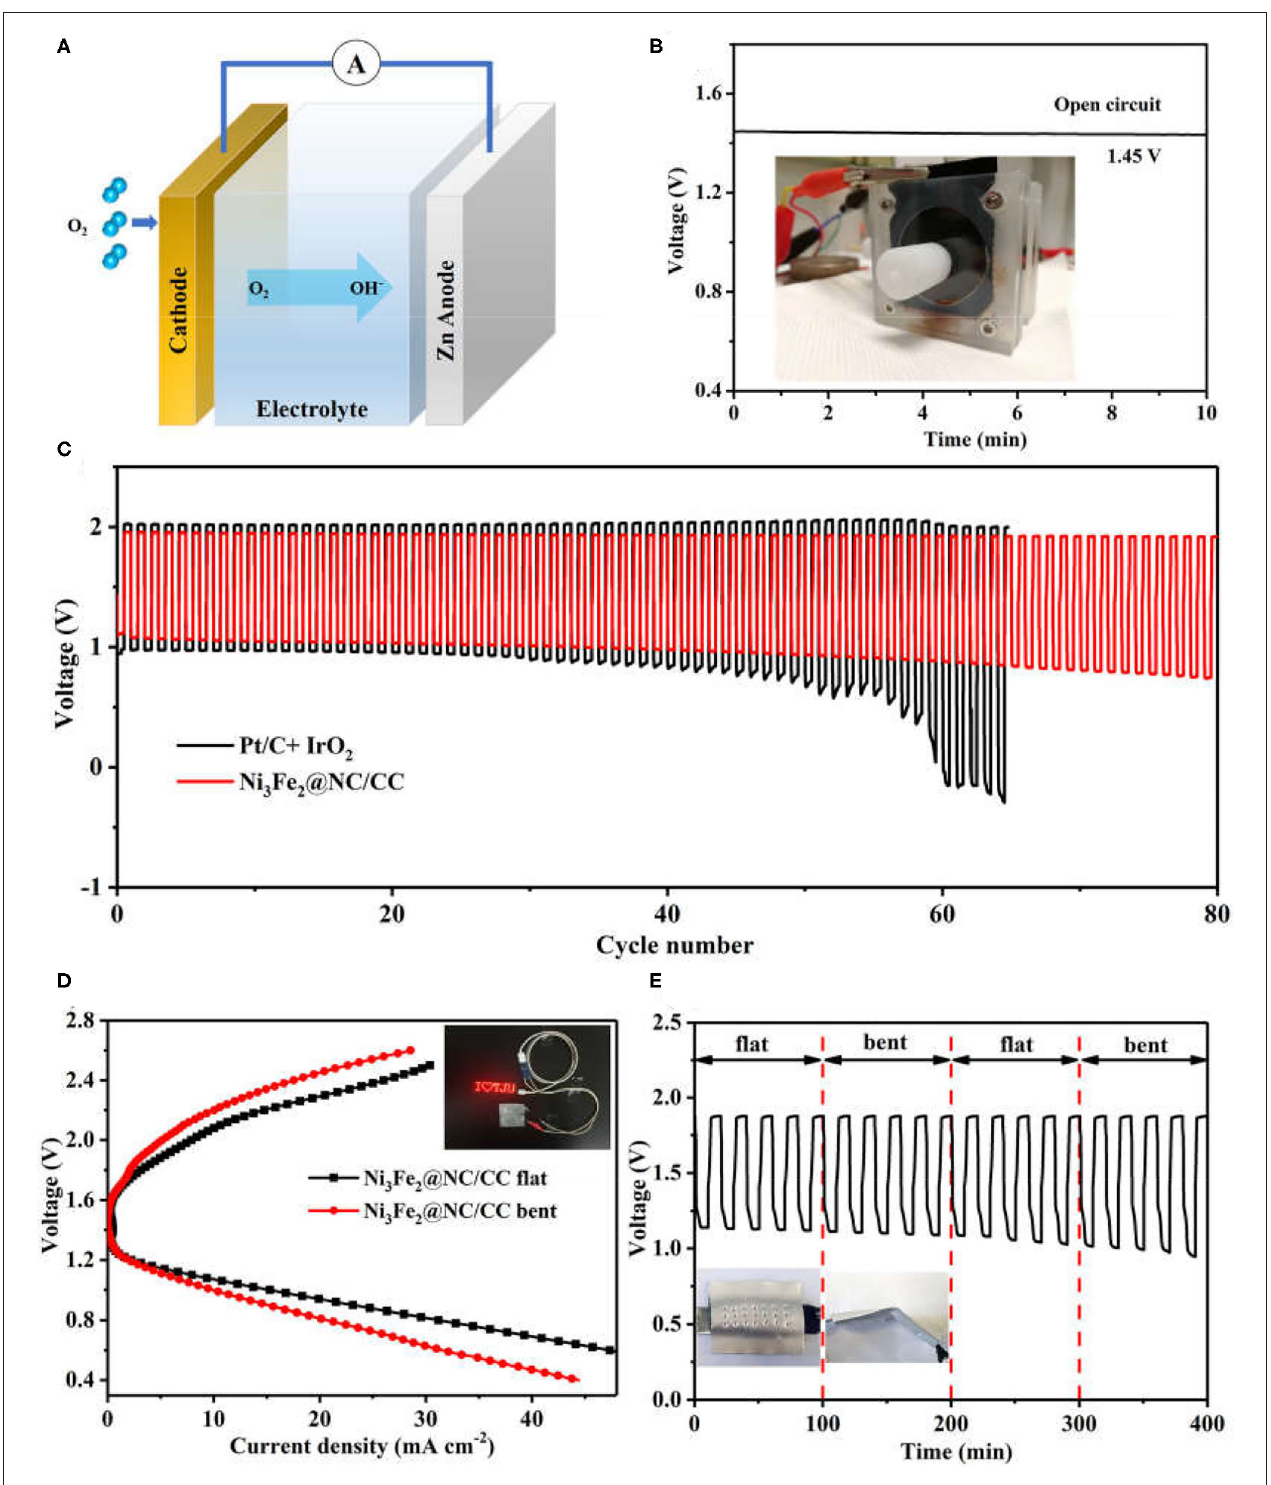
FIGURE 5 | (A) Schematic configuration of an aqueous Zinc-air battery. (B) Open-circuit voltages of Ni 3 Fe 2 @NC/CC based zinc-air batteries. Inset shows a Zinc-air battery under test. (C) Cycling performance of rechargeable zinc-air batteries. (D) Discharge and charge polarization curves and (E) cycling performance of Ni 3 Fe 2 @NC/CC-based flexible battery at 2mA cm − 2 . Inset shows a LED screen powered by Ni 3 Fe 2 @NC/CC-based zinc-air batteries.